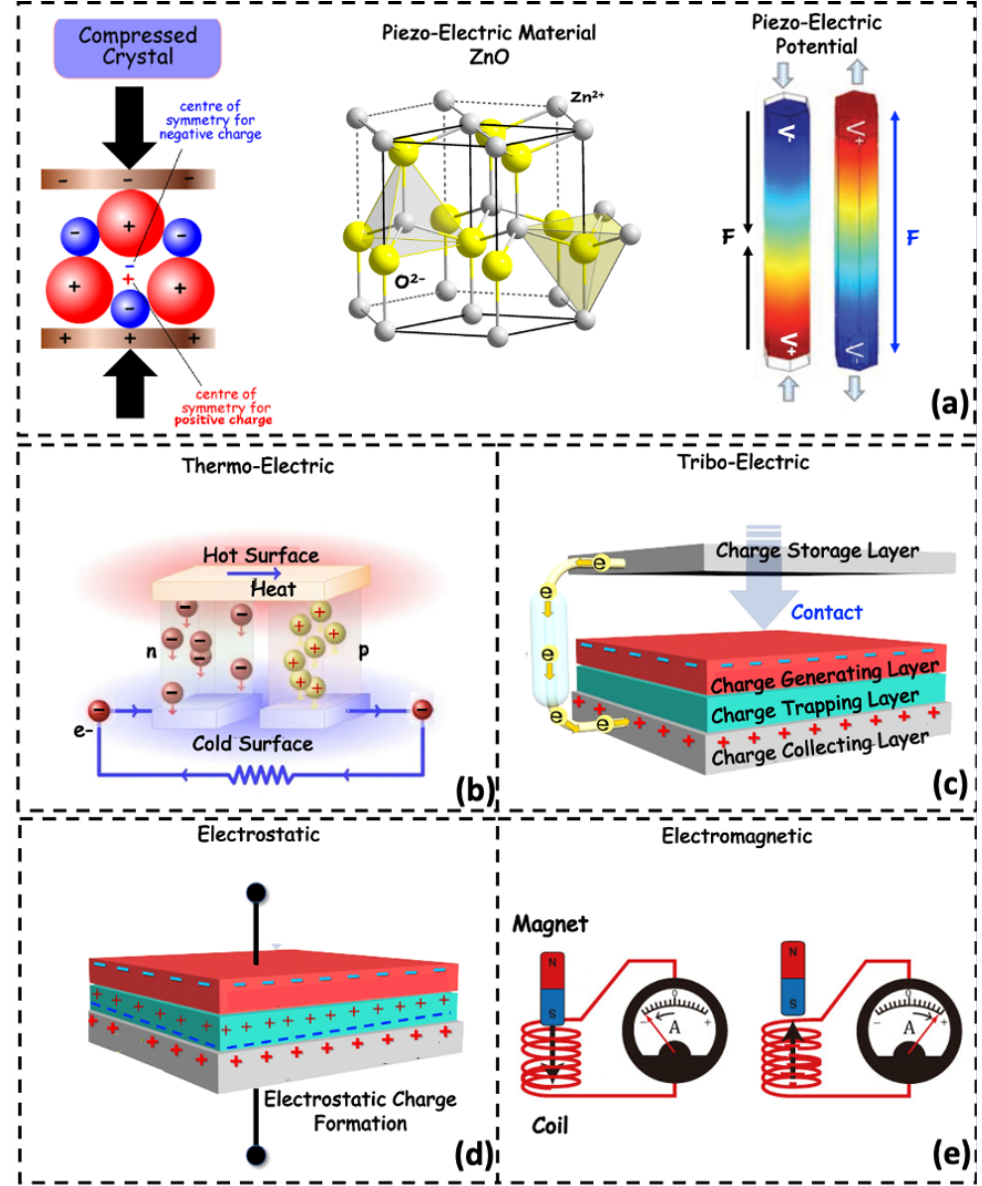
Figure 3. Schematic illustration for working principle of various types of biomechanical energy harvesting schemes. ( a ) Development of electric potential while the piezoelectric crystals are com- pressed/strained. ( b ) The temperature gradient between a hot and a cold surface on a thermoelectric material develops an electric potential and a resultant current flow. ( c ) Charge generation at the interface of triboelectric pair materials by contact friction. ( d ) Charge storage on the dielectric mate- rial inside two metal contacts by electrostatic action. The charges deposited in the triboelectric and electrostatic scheme store energy by capacitive coupling. ( e ) A moving magnet inside a coil produces a potential difference by Faraday